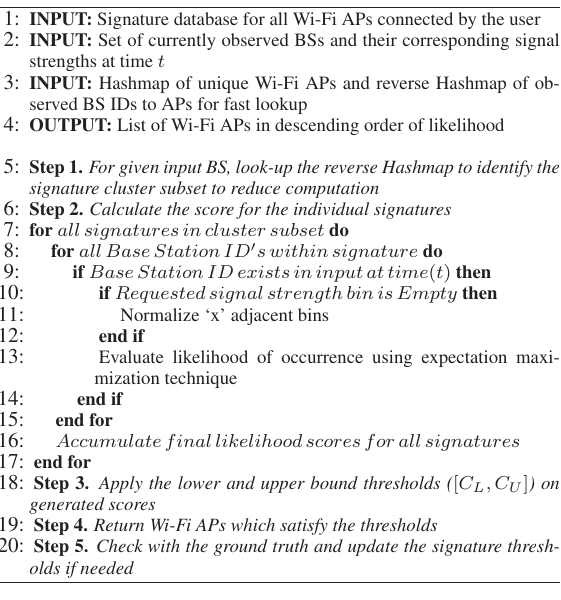
Algorithm 1: ATiS Signature Score Generation